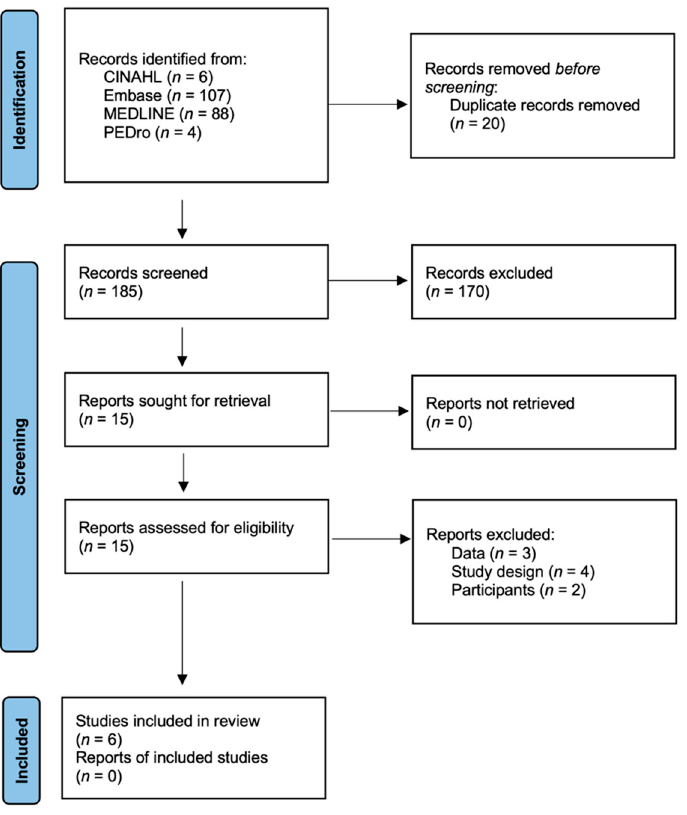
Figure 1. Preferred Reporting Items for Systematic Reviews and Meta-Analysis flow diagram.